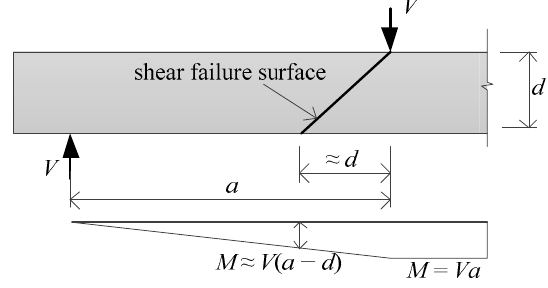
Figure 2. Critical section in ACI model.